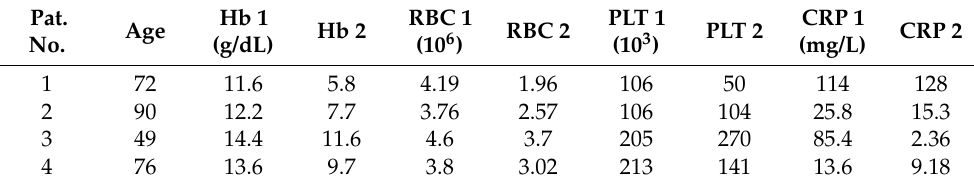
Table 1. Basic laboratory parameters on admission and after onset of the bleeding.